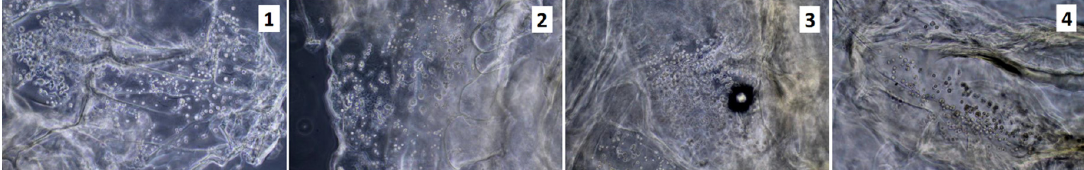
Figure 11. Uncoated with fibronectin, unsterilized scaffolds, rinsed in antibiotics; 3rd of the cell (sample 1—chitosan crosslinked with adipic and malonic acid; sample 2—chitosan crosslinked with adipic and l -glutamic acid; sample 3—chitosan crosslinked with adipic, l -glutamic and malonic acid; sample 4—chitosan crosslinked with adipic and levulinic) culture.